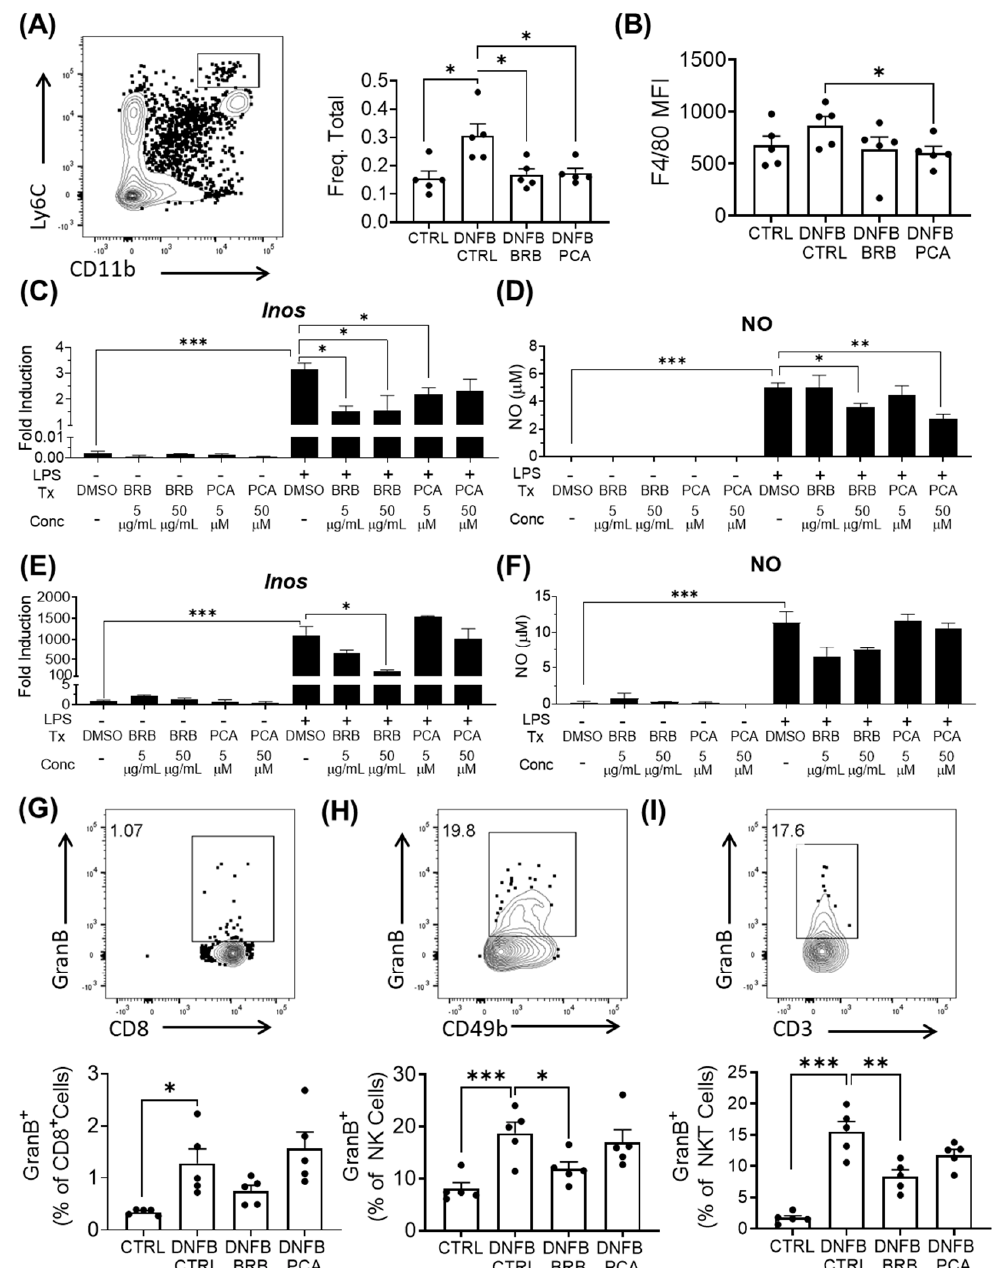
Figure 5. Mediators of e ff ector responses during CHS are inhibited by BRB and PCA. ( A ) Frequency of CD11b + Ly6C hi Ly6G - monocytes among total live cells in the spleen, determined by flow cytometry. A representative flow plot of the gated population is shown. ( B ) Mean fluorescent intensity (MFI) of F4 / 80 expression by CD11b + Ly6C hi monocytes determined by flow cytometry. ( C ) Fold induction of Nos2 expression in RAW264.7 cells at 24 h after incubation. ( D ) Nitric oxide production by RAW264.7 macrophages, 24 h after LPS stimulation. ( E ) Fold induction of Nos2 expression by activation study bone marrow-derived dendritic cells at 24 h after LPS stimulation. ( F ) Nitric oxide production by activation study bone marrow-derived dendritic cells 24 h after LPS stimulation. ( G – I ) Frequencies of granzyme B production by lymph nodal ( G ) CD8 + T cells, ( H ) CD49b + CD3 − NK cells, and ( I ) CD49b + CD3 + NKT cells determined by flow cytometry. Representative flow plots of the gated populations are shown. * p -value < 0.05; ** p -value < 0.01; *** p -value < 0.005 for comparisons between DNFB-challenged mice fed control diets and comparison groups using Student’s t test, and for comparisons between DMSO control samples and comparison groups.